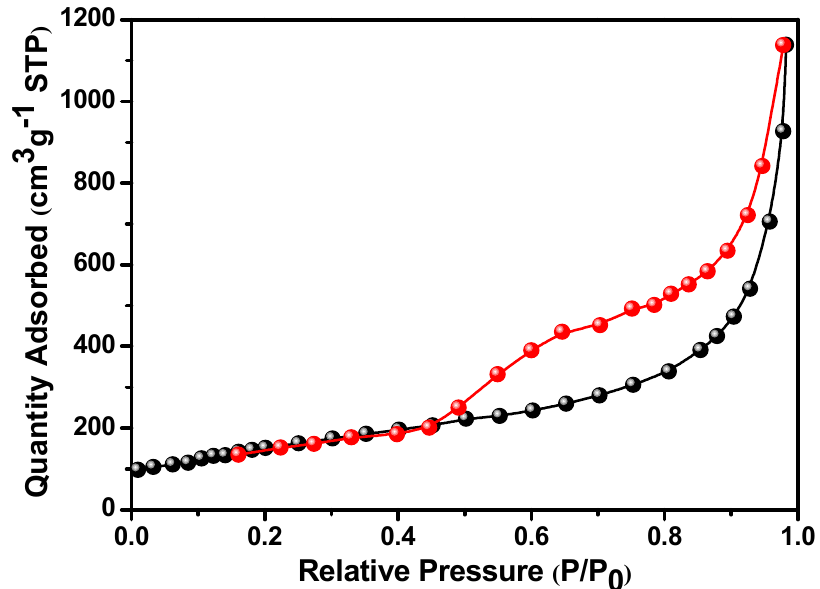
Figure 3. Nitrogen adsorption/desorption isotherms of rice husk-derived activated carbon.